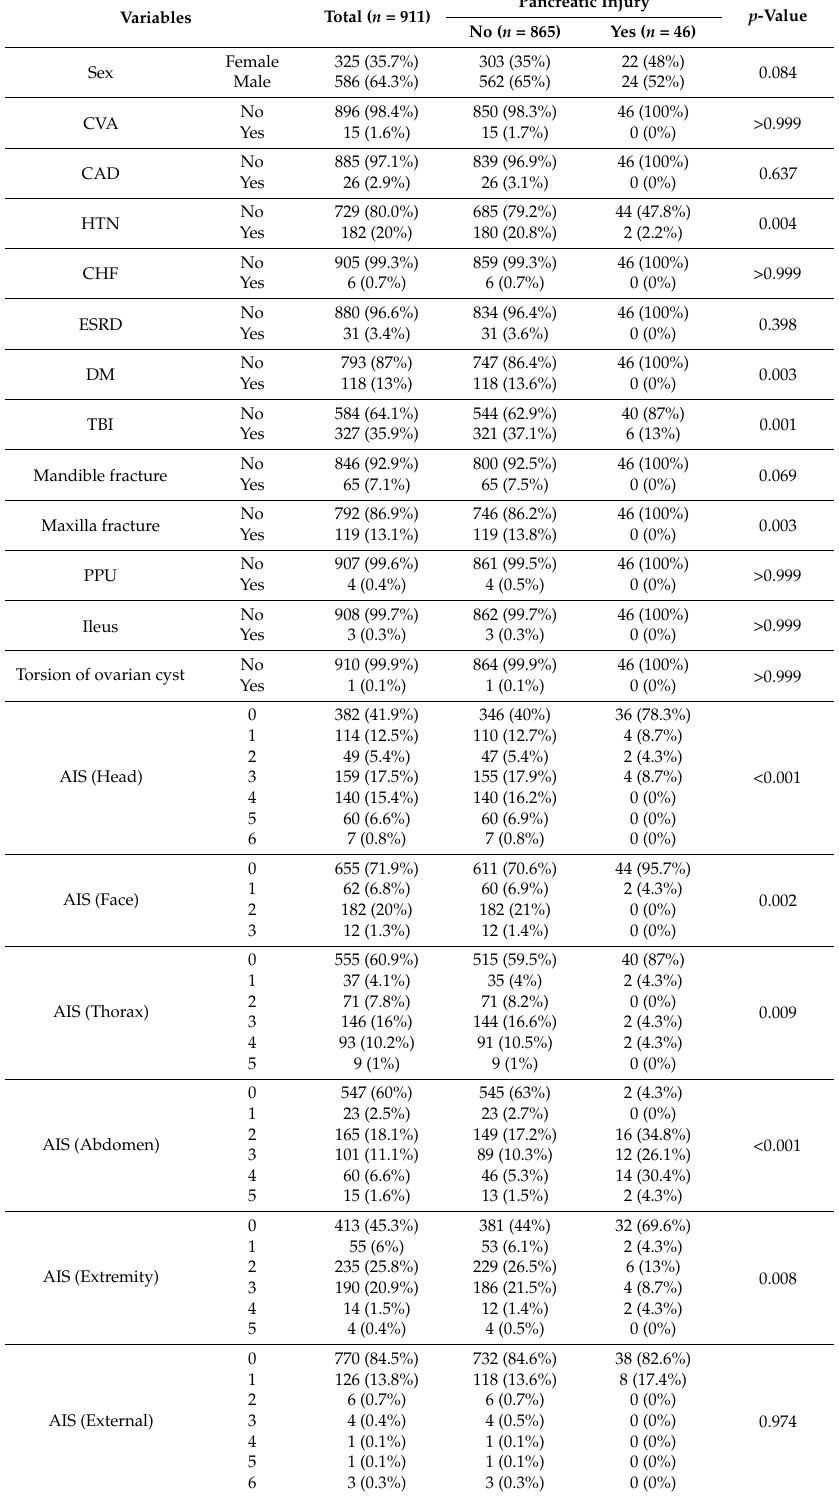
Table 1. Comparison of categorical variables of patient and injury characteristics, used to establish the decision tree model, between patients with and without pancreatic